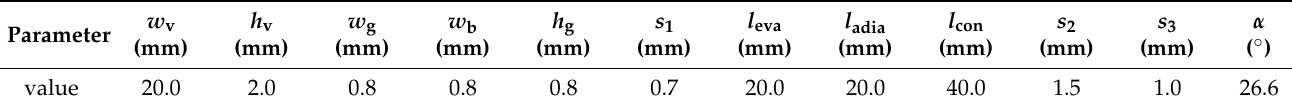
Figure 3. Geometric structure of the MGFHP: ( a ) 3D structure; ( b ) Cross-section in the z -direction. Table 1. Geometric parameters of the MGFHP.